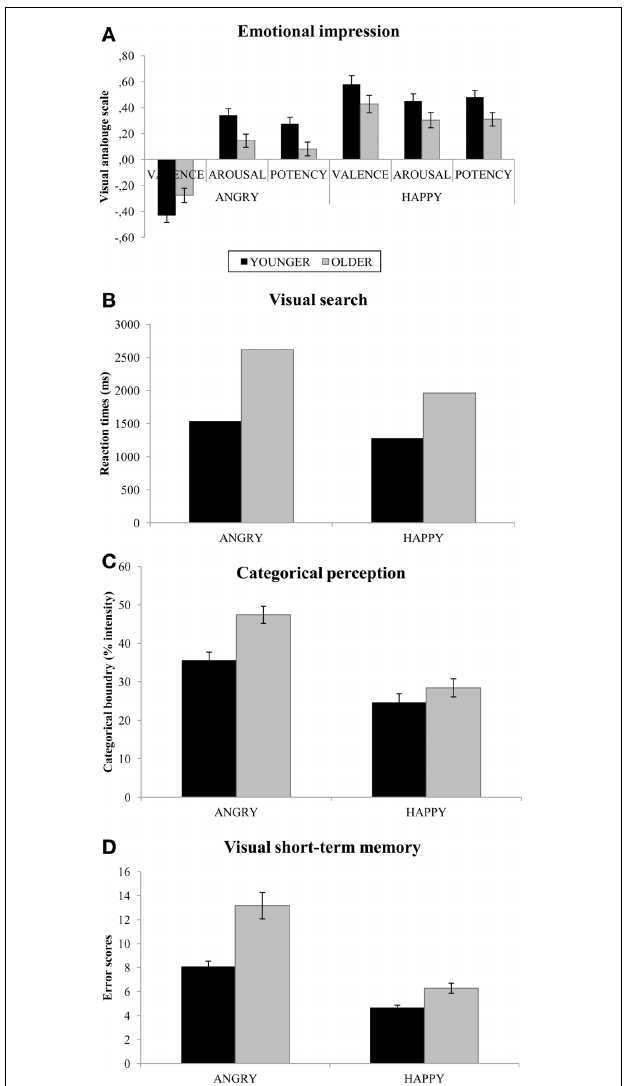
FIGURE 3 | Mean (SE) performance in the rating task (A), visual search task (B), categorical perception task, (C) and visual short-term memory task (D) separately for expression and age. Note. Error bars represent standard error. Results of the ANOVAs and t -tests for age differences are presented in the result